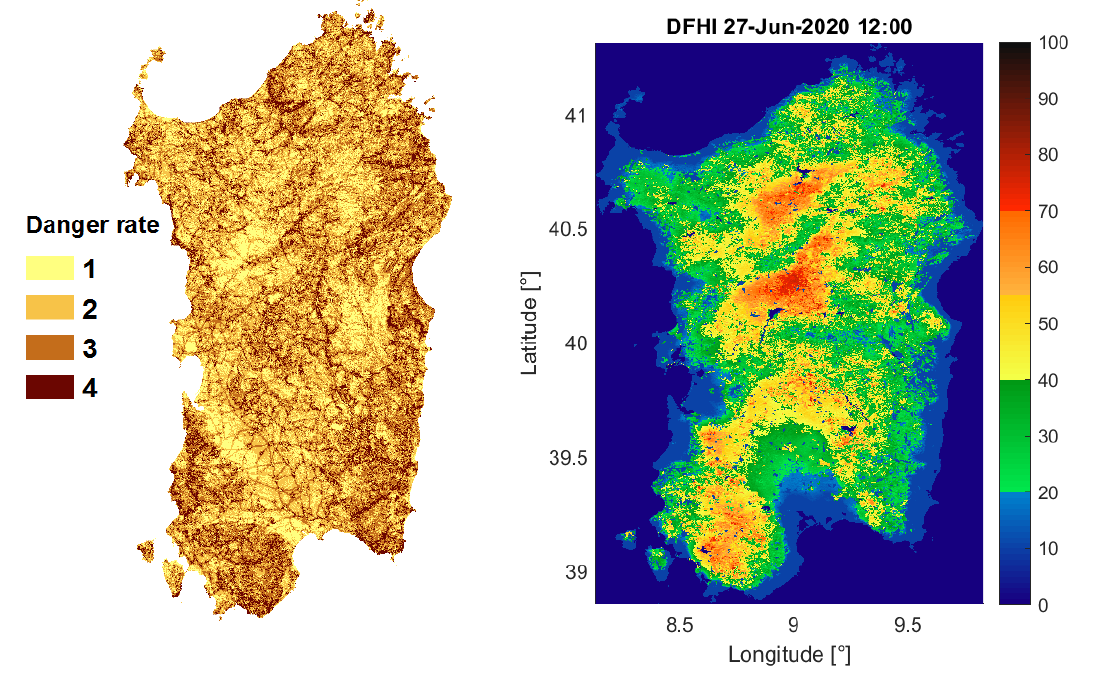
Figure 1. On the left, a map of static fire danger, an example of a static method of fire hazard estimation. On the right, a typical Daily Fire Hazard Index (DFHI) map, an example of a dynamical method for fire hazard